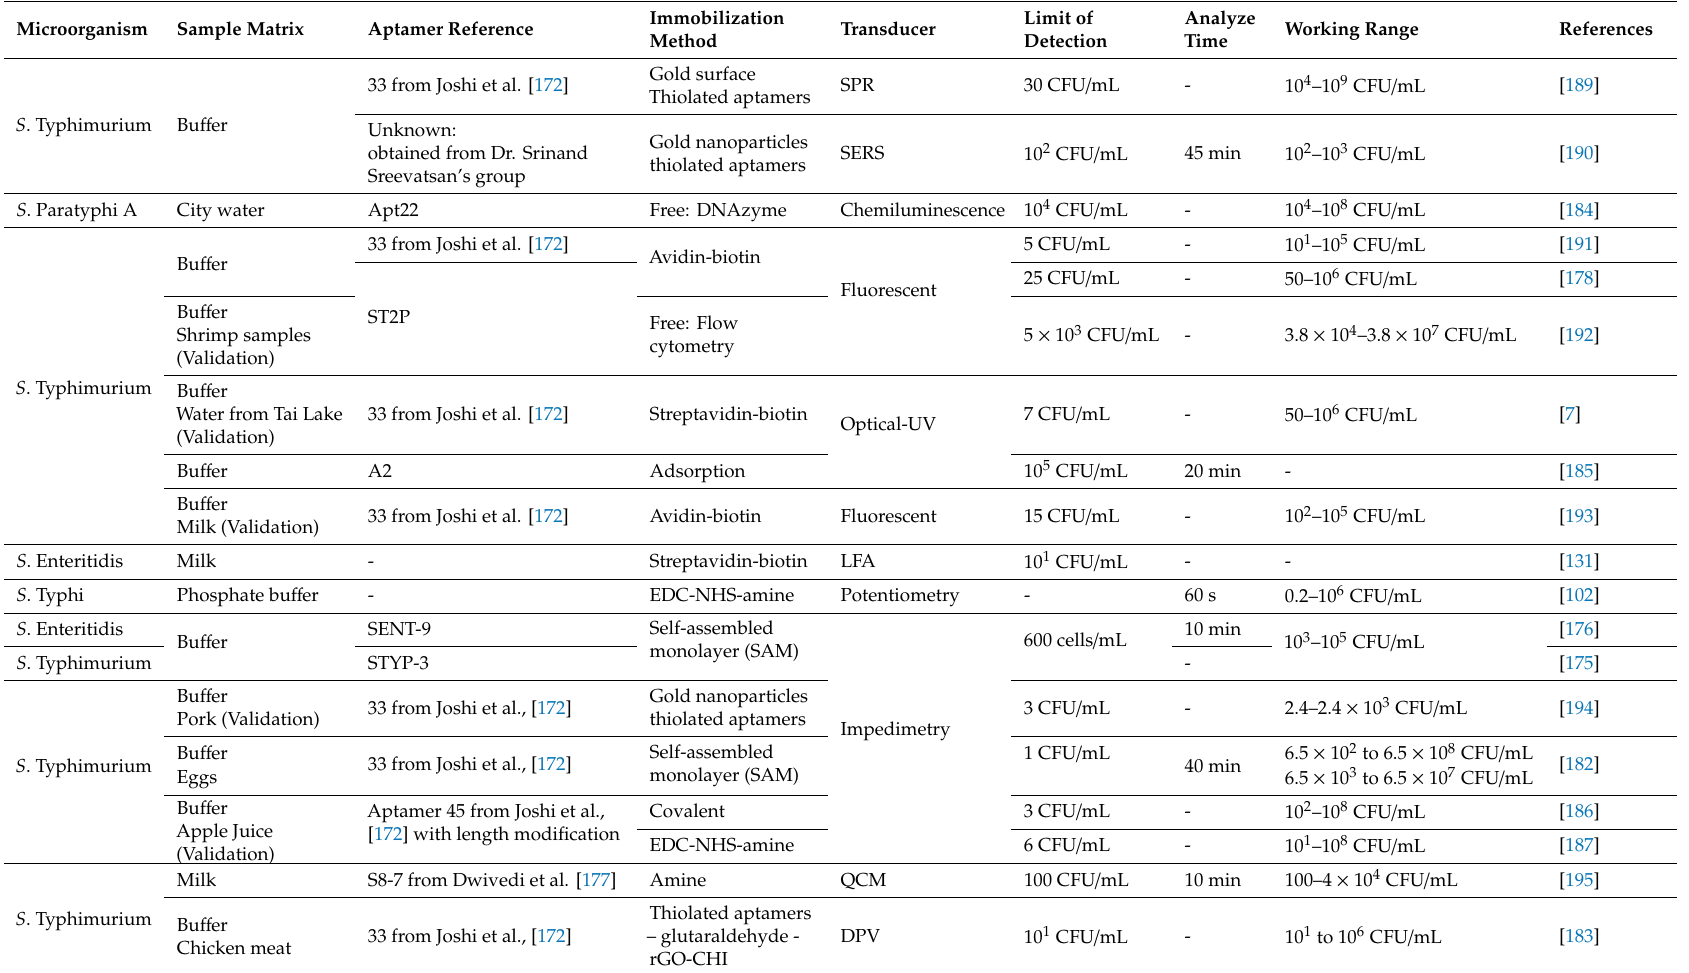
Table 5. Aptasensors for Salmonella strains detection in food